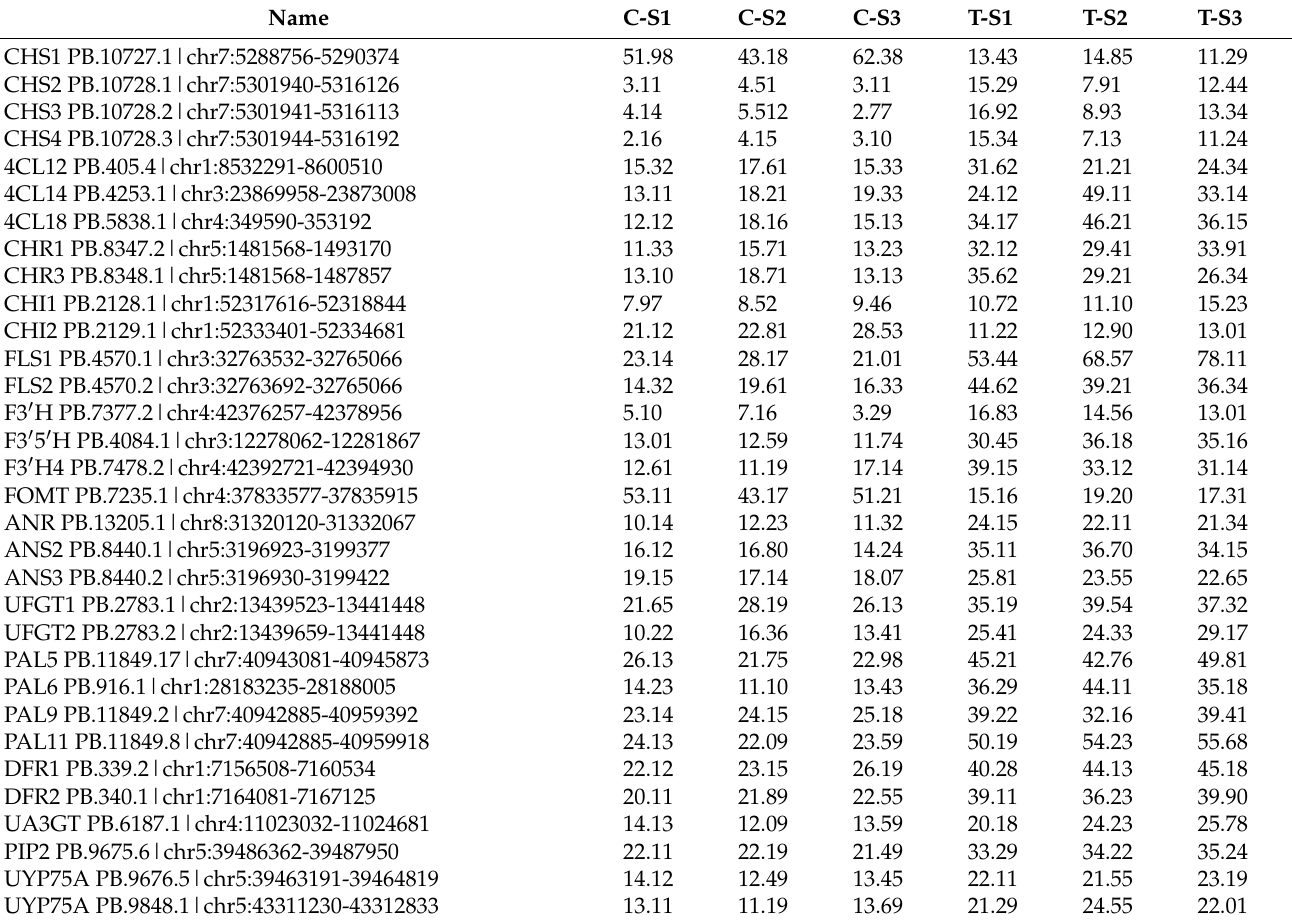
Table 3. Statistics on the FPKM values of 15 candidate genes in closed